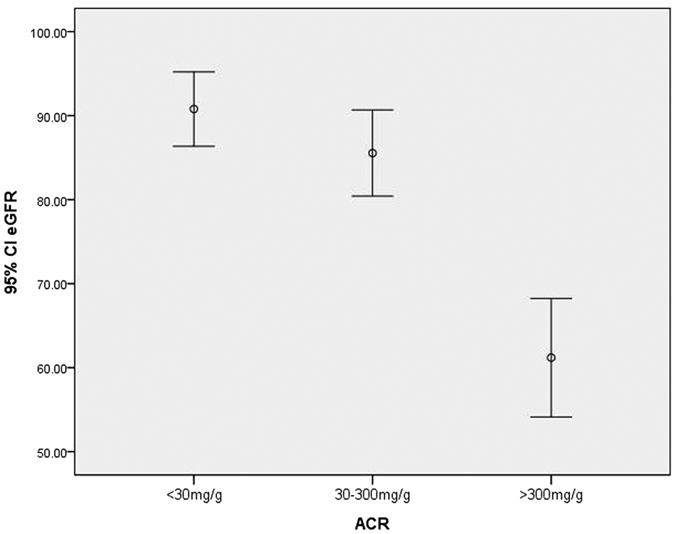
The mean and 95% CI of FT4 and TT4 in CKD stage.CKD stage 1: eGFR ≥ 90 ml/min; CKD stage 2: 90 ml/min > eGFR ≥ 60 ml/min; CKD stage 3: 30 ml/min > eGFR ≥ 60 ml/min; CKD stage 4: 15 ml/min > eGFR ≥ 30 ml/min; CKD stage 5: eGFR < 15 ml/min; CI: confidence interval; FT4: free T4 (pmol/L); TT4: total T4 (mmol/L).